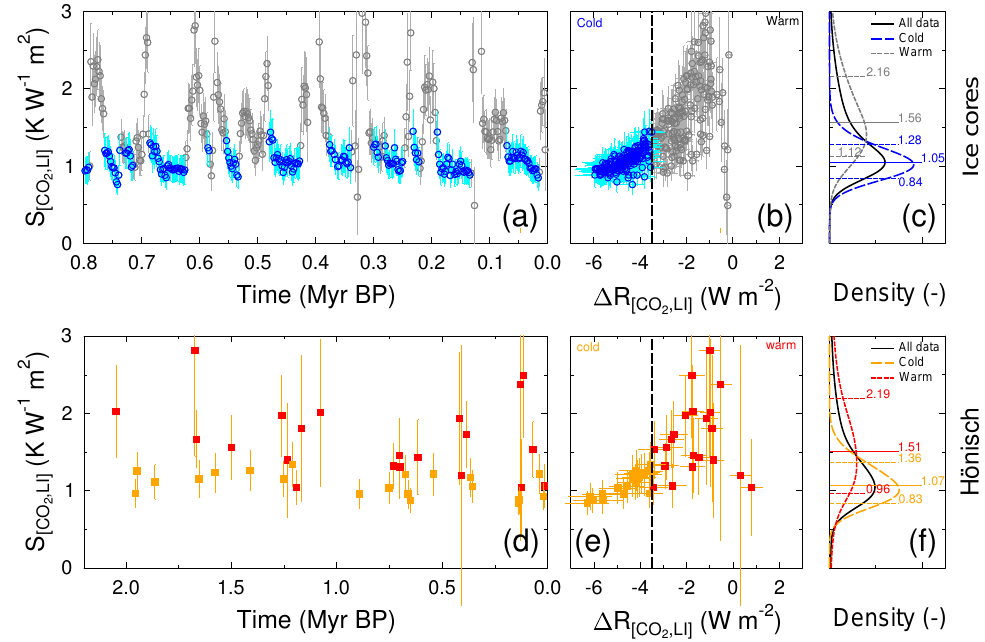
. Only data with their mean in S [ CO in the range [ 0 , 3 ] KW − 1 m 2 Figure 8. Calculating specific equilibrium climate sensitivity, S [ CO 2 ,LI ] 2 ,LI ] are analysed and plotted. Panel (a) : ice-core-based time series of pointwise calculations of S [ CO for the last 0 . 8Myr. Panel (b) : same 2 ,LI ] data as in (a) in a scatter plot of S [ CO against radiative forcing (cid:49)R [ CO . Panel (c) : probability density distribution of ice-core-based 2 ,LI ] 2 ,LI ] S [ CO < − 3 . 5Wm − 2 ) and “warm” periods ( (cid:49)R [ CO > − 3 . 5Wm − 2 ) are analysed separately. . Data from “cold” periods ( (cid:49)R [ CO 2 ,LI ] 2 ,LI ] 2 ,LI ] Labels in (c) denote 16th, 50th, and 84th percentile. Panels (d,e,f) : same as (a,b,c) , but for the Hönisch data over the last 2 .